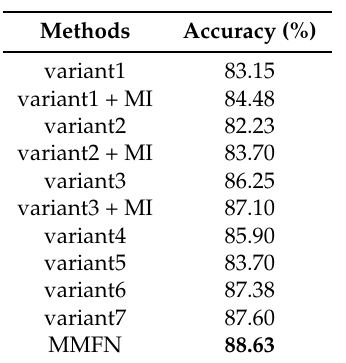
Table 1. The recognition accuracy (%) of the proposed multi-evidence and multi-modal fusion network (MMFN) as well as its variants. The notation “+” indicates the concatenation